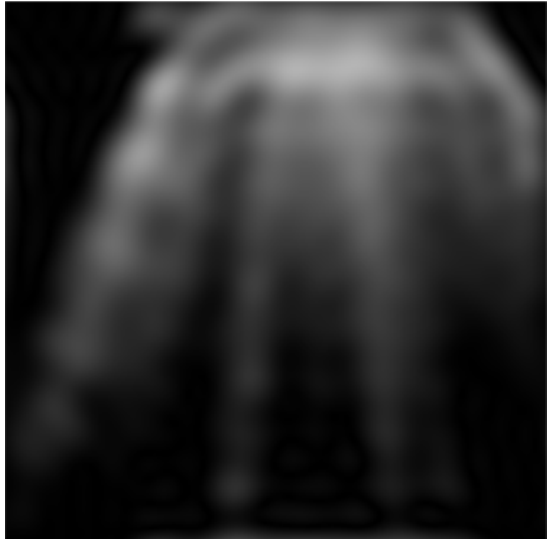
Figure 4. Direct and inverse Fourier transform on a grayscale